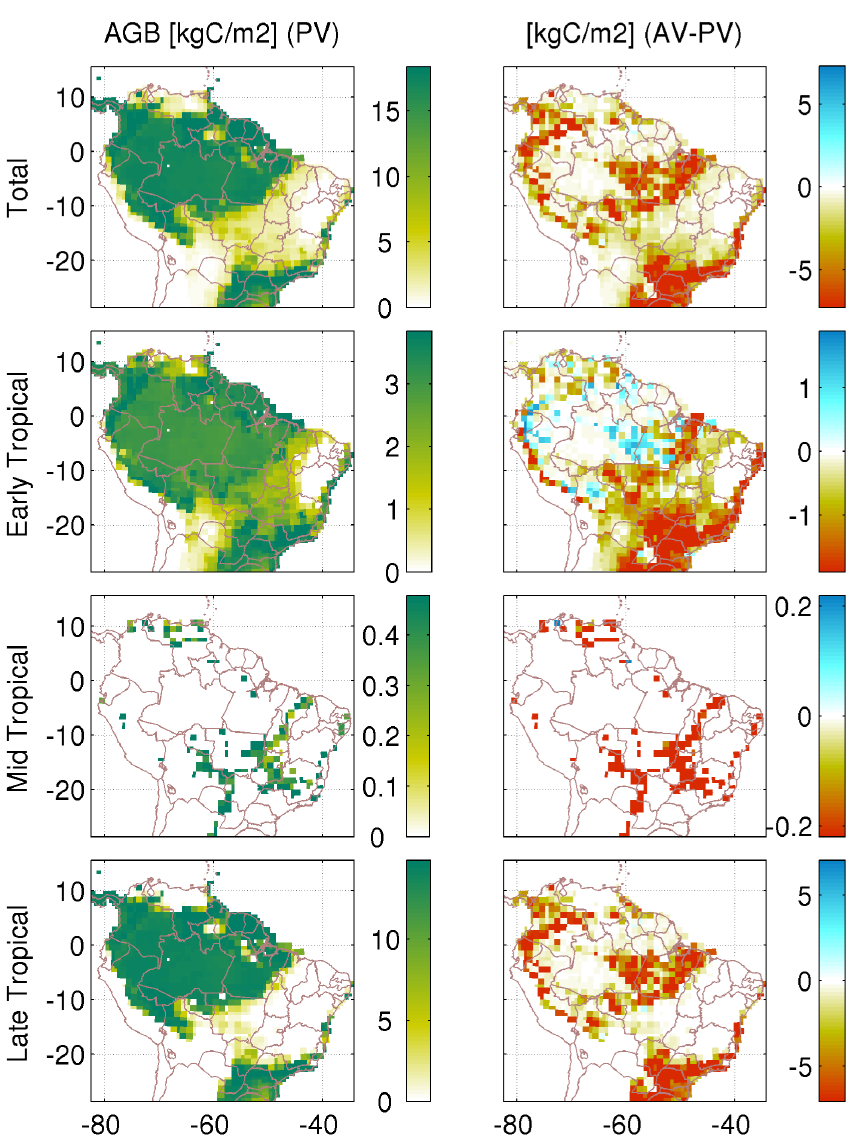
Figure 2. Regional maps of total above-ground biomass (AGB) (kgm − 2 ) from the ED2 initial condition. The left column indicates results are from the potential vegetation condition, the right column is the relative differences between the actual and potential scenarios, (AGB AV – AGB PV ). Each row represents the partitioning of the above-ground biomass into respect plant functional types. “Early Tropical”, “Mid Tropical” and “Late Tropical” refer to broadleaf tropical evergreen plant functional